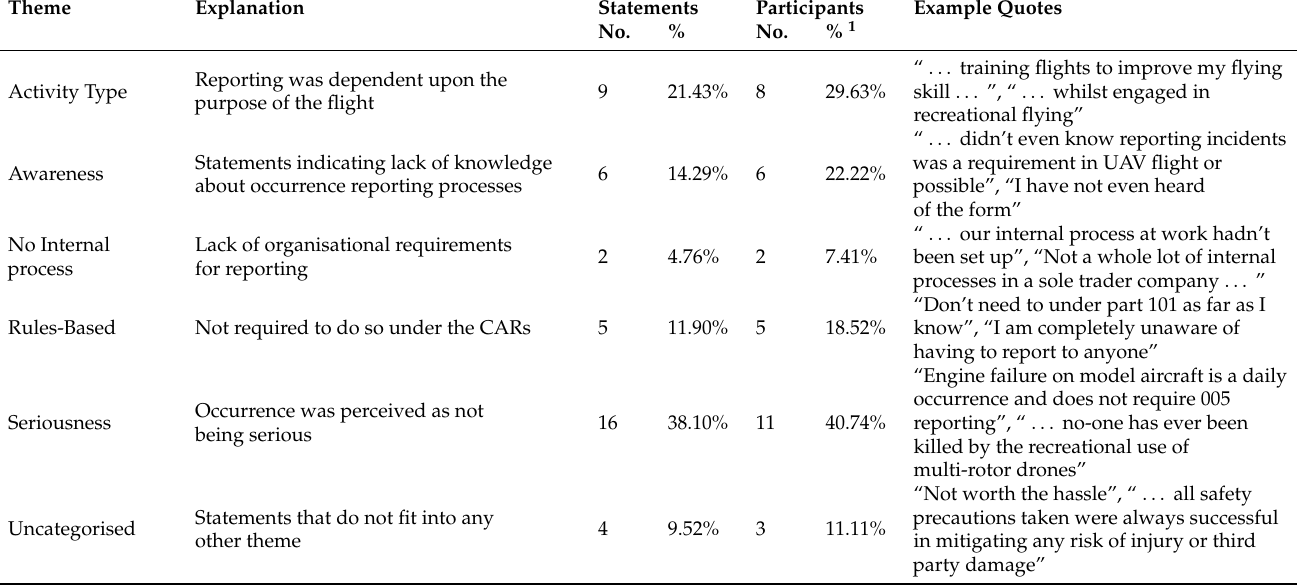
Table 8. Reasons for not reporting occurrences using CA005RPAS forms or internal systems.